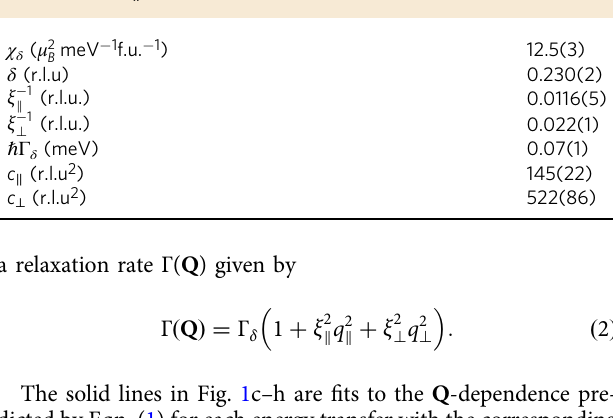
Table 1 Fitted susceptibility parameters for B = 7.95 T and c T = 50 mK. c ∥ and ⊥ are derived from other